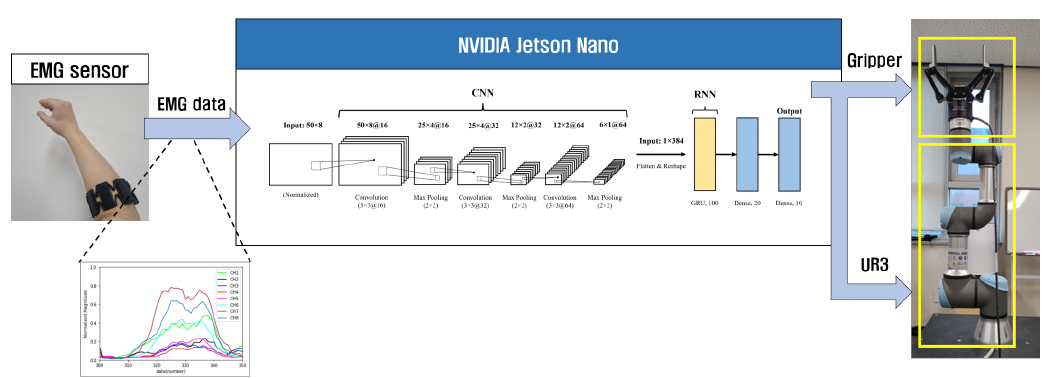
Figure 1. Proposed system configuration. EMG data are transmitted from the EMG sensor to the ROS environment on an NVIDIA Jetson Nano. The ROS-based embedded system controls a gripper and UR3 manipulator using the gesture classifier trained via deep